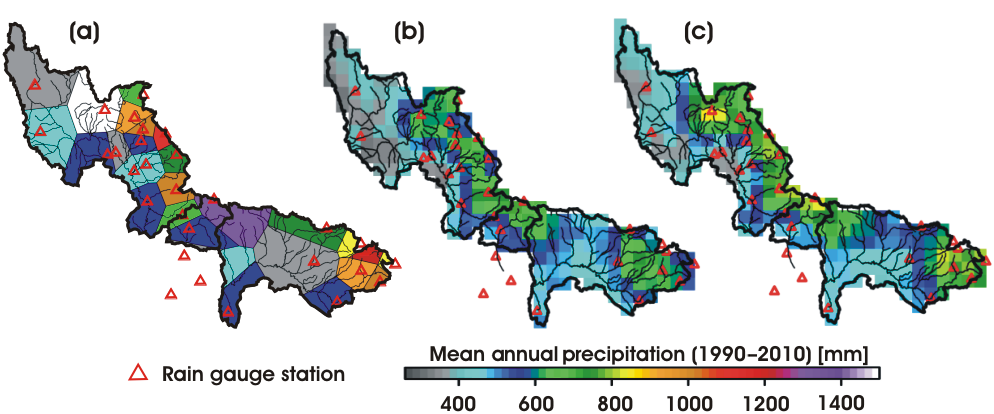
Figure A1. Spatial distribution of long-term (1990–2010) annual rainfall as measured by (a) Thiessen polygons from 30 daily rain gauge stations, (b) raw NLDAS and (c) locally bias corrected NLDAS estimations.